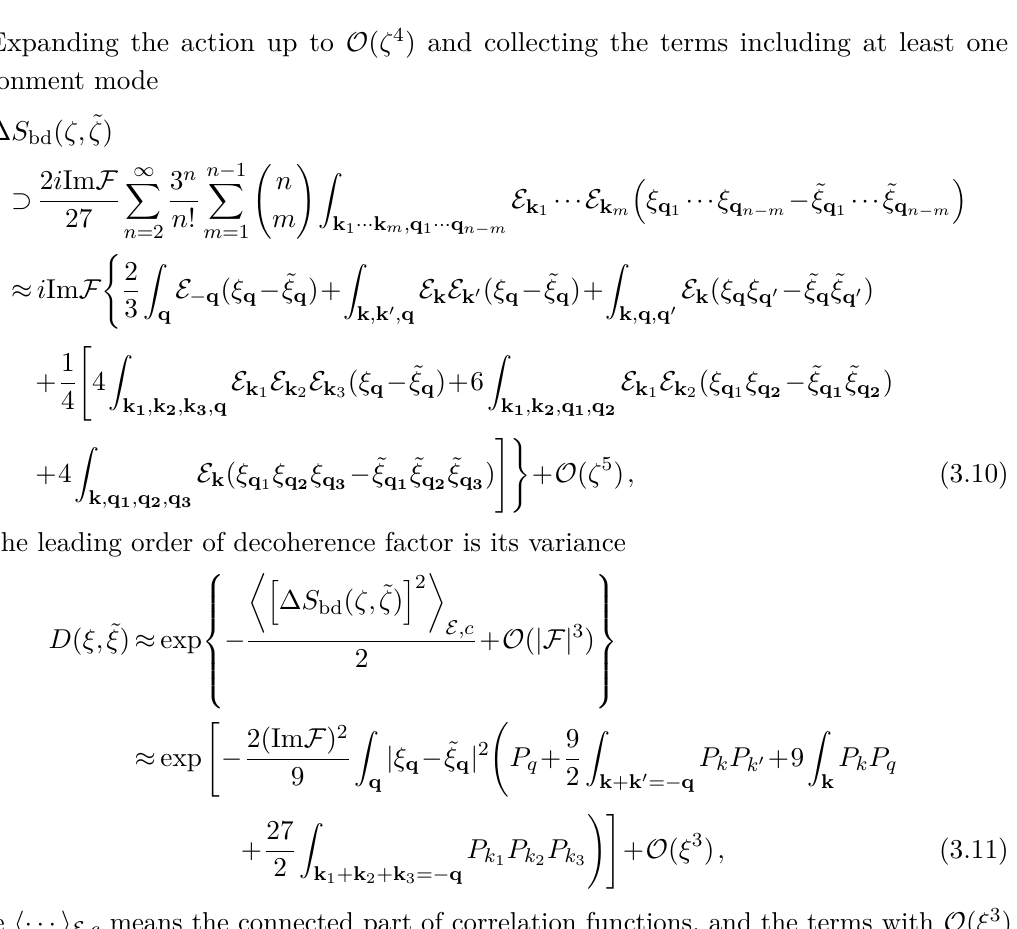
Figure 1 . The diagrams of the four terms in